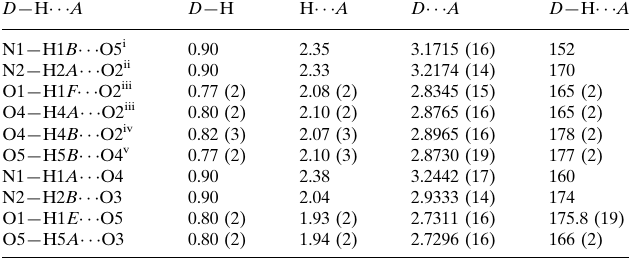
Hydrogen-bond geometry (A˚ , (cid:3)